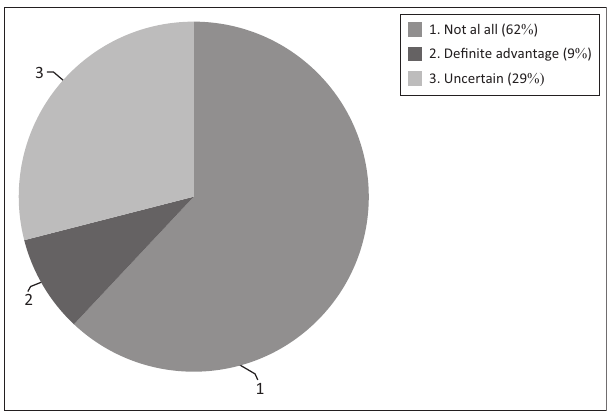
FIGURE 11: The views of participants about the internal capital adequacy assessment process as a competitive advantage.